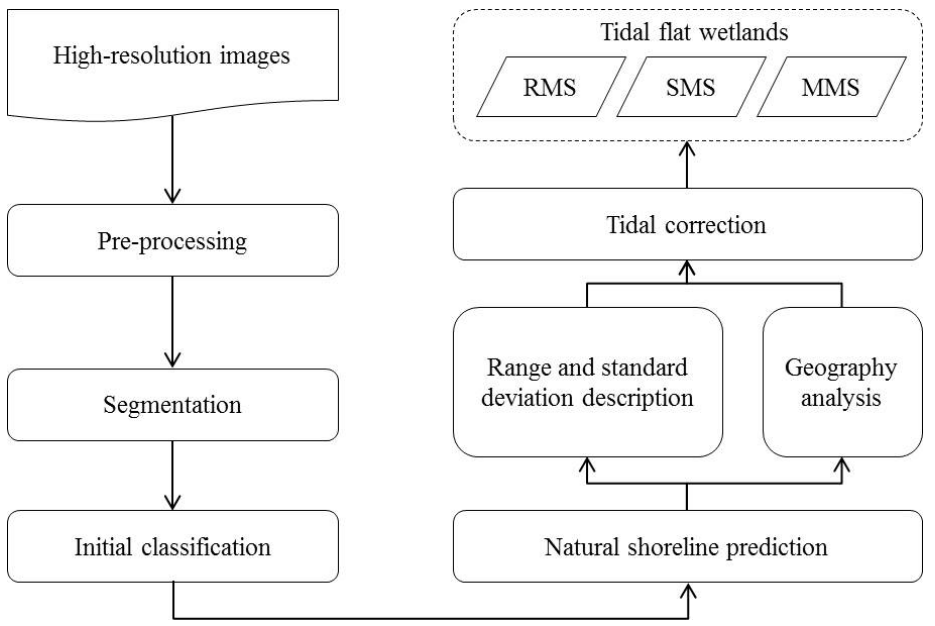
Figure 2. Overall flowchart of the proposed method.